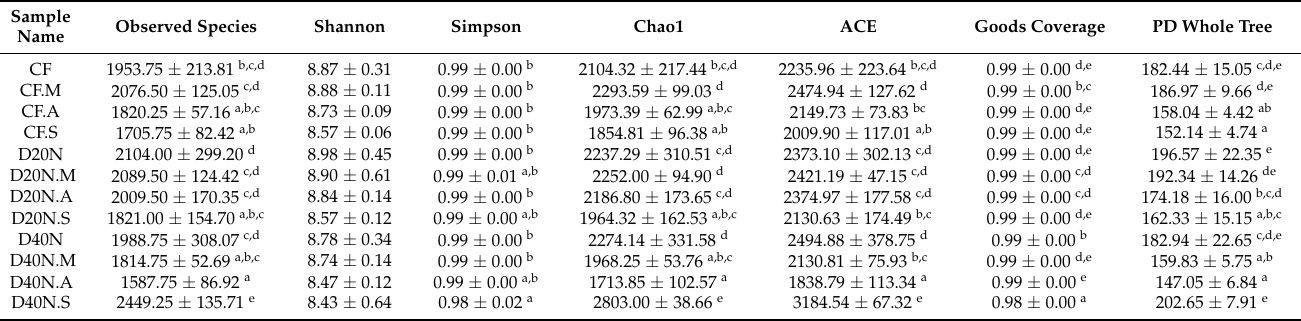
Table 2. Statistic results of alpha diversity